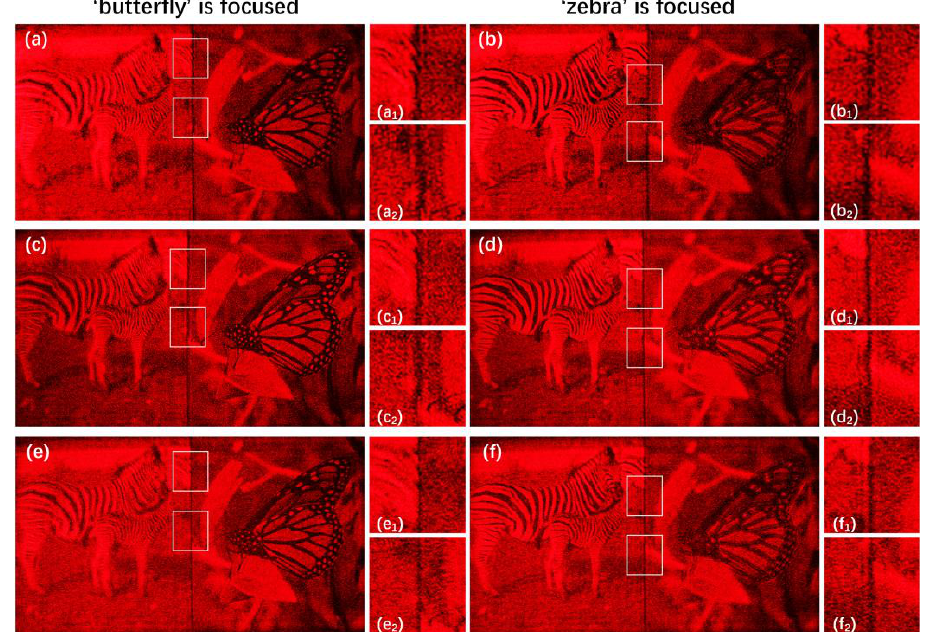
Figure 10. ( a , b ) are the optical reconstructed results of the SGD method with weighted complex loss function when the mask is not used in the process of the diffraction, ( c , d ) are the optical reconstructed results of the SGD method with complex loss function when the mask is used in the process of the diffraction, and ( e , f ) are the optical reconstructed results of the proposed method when the distance 𝑧 𝑟 is 230 mm and Δz is 30 mm. ( a 1 – f 1 ) and ( a 2 – f 2 ) are details of ( a – f ) in the white box. The comparisons of the optical reconstructed results between the SGD method with amplitude loss function and the proposed method are given in Figure 11. As shown in Figure 11a – d, the optical reconstructed results of the SGD method with amplitude loss function are not consistent with the simulation results, which are still contaminated by speckle noises because the optical reconstruction system is not an ideal system and it aggravates the nonuniform status of the phase distribution. The optical reconstructed images of the proposed method are shown in Figure 11e–h, and their display effect is more excellent than that of the SGD method with amplitude loss function. Compared with the SGD method with amplitude loss function, the optical reconstructed images generated by the proposed method agree well with the simulation results, and the speckle noise is suppressed well. Because the proposed method optimizes phase and amplitude simultaneously, the phase distribution of the optical reconstructed image is more uniform than that of the SGD method with amplitude loss function. Therefore, the influence from the error of a nearly uniform phase distribution is smaller than a nonuniform phase distribution even in a non-ideal optical reconstruction system.